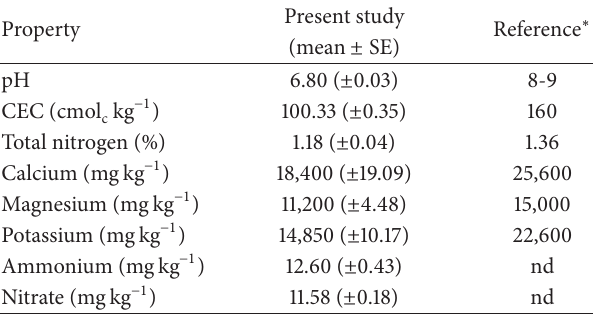
Table 2: Selected chemical properties of clinoptilolite zeolite. Table 3: Selected chemical properties of compost by cocomposting rice straw and chicken